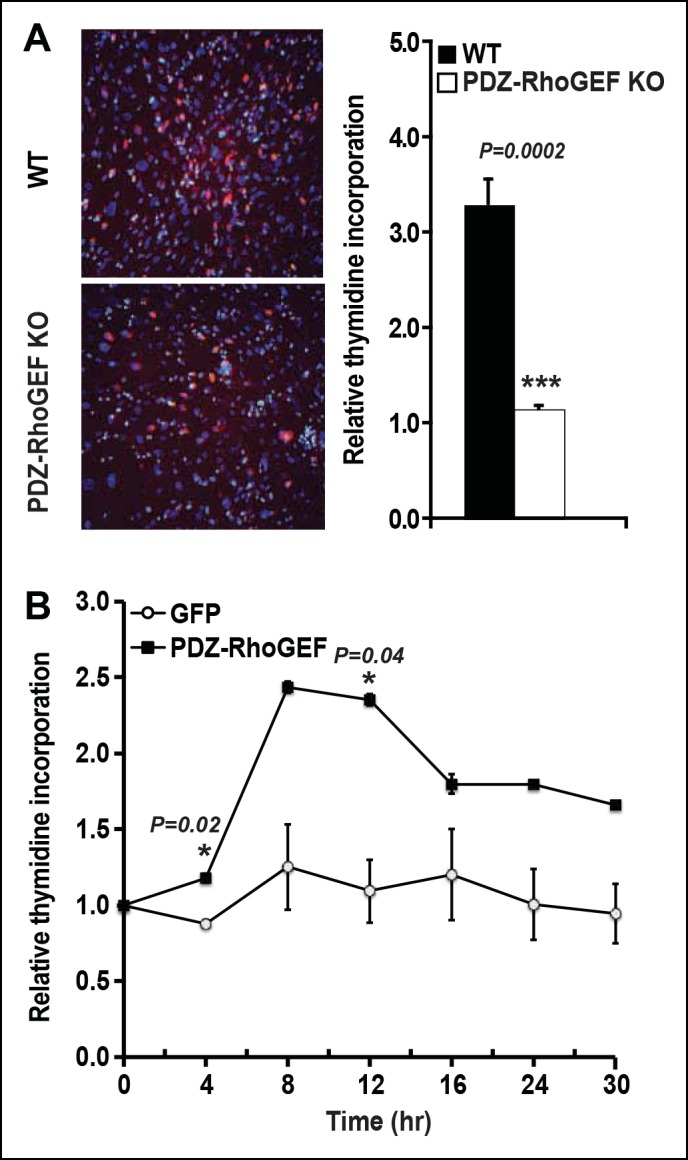
PDZ-RhoGEF regulates clonal expansion during adipocyte differentiation in vitro.(A)Reduction of post-confluent mitosis determined by [3H}-thymidine incorporation and mitotic clonal expansion in PDZ-RhoGEF KO MEFs during in vitro adipogenesis, pulsed-chased by BrdU + (Red) and counterstained by DAPI (Blue). (B)Overexpression of PDZ-RhoGEF resulted in increased DNA synthesis in 3T3-L1 cells after induction of adipogenesis. Statistical significance was calculated by a Student’s t test using Excel software (*p<0.05, **p<0.01, ***p<0.001).